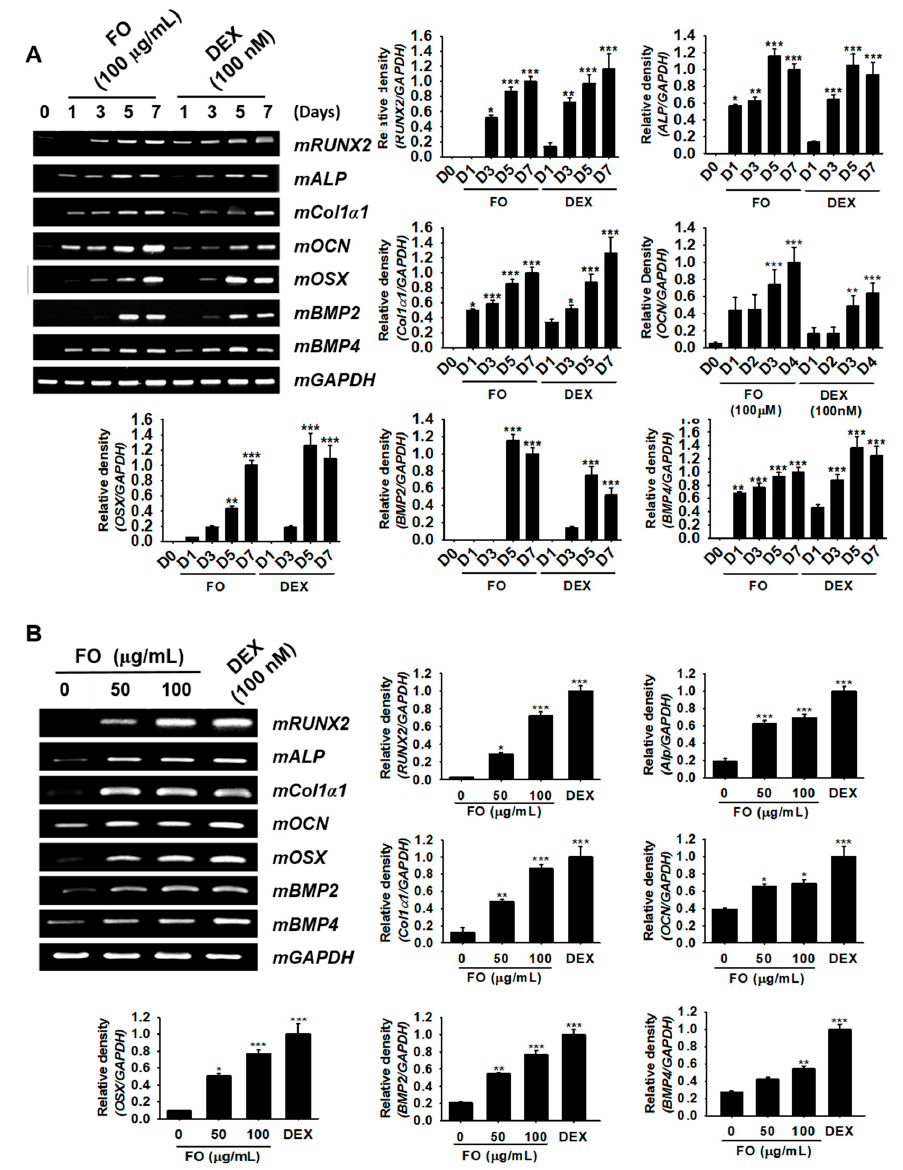
Figure 2. FO upregulates the specific marker gene expression responsible for osteoblast differentiation in MC3T3-E1 cells. ( A ) MC3T3-E1 cells were treated with 100 μ g/mL of FO and 100 nM DEX for 7 days. The expression of mRUNX2 , mALP , mCol1a1 , mOCN , mOSX , mBMP2 , and mBMP4 was measured on day 1 (D1), day 3 (D3), day 5 (D5), and day 7 (D7). ( B ) The cells were also treated with 50 μ g/mL and 100 μ g/mL of FO or 100 nM DEX for 5 days. The expression of mRUNX2 , mALP , mCol1a1 , mOCN , mOSX , mBMP2 , and mBMP4 , was observed. mGAPDH was used as a house keeping gene. Significant di ff erences among the groups were determined using the one-way ANOVA followed by Bonferroni correction. All data are presented as mean ± SEM (*** p < 0.001, ** p < 0.01, and * p < 0.05 versus untreated group). FO; fermented extract of C. gigas and DEX;